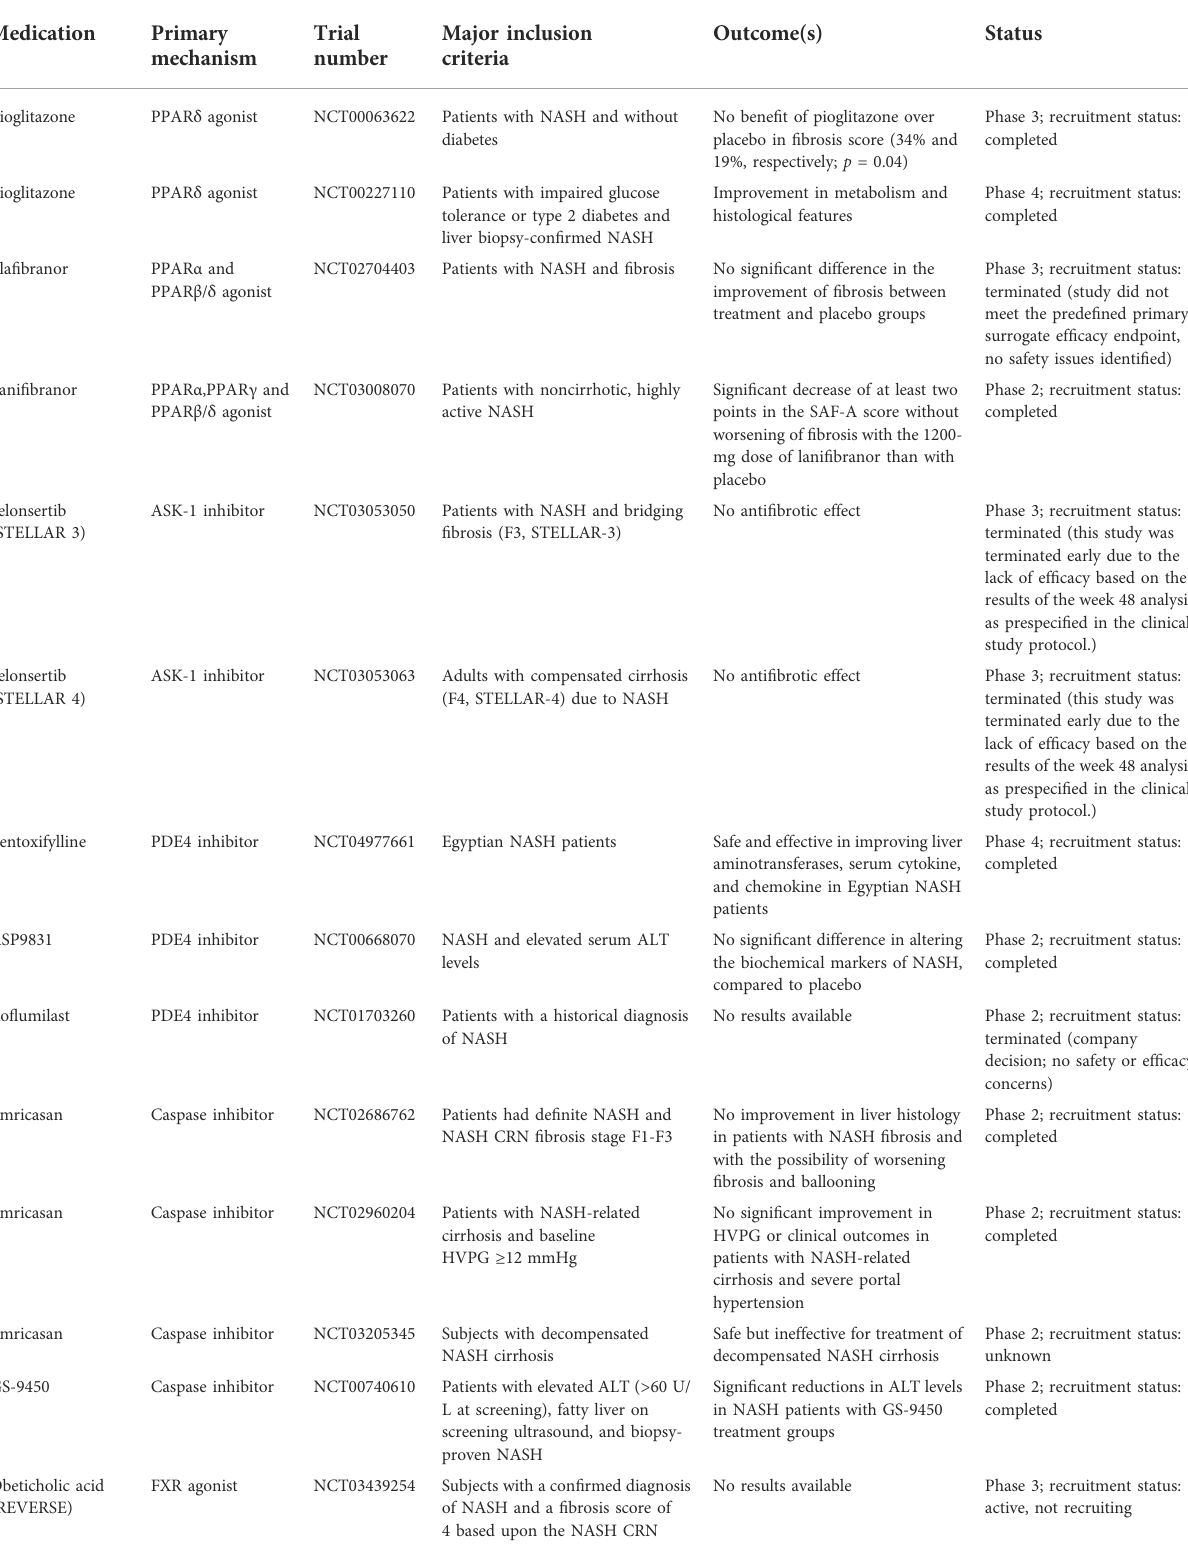
TABLE 1 Clinical trials of medications associated with HSCs for